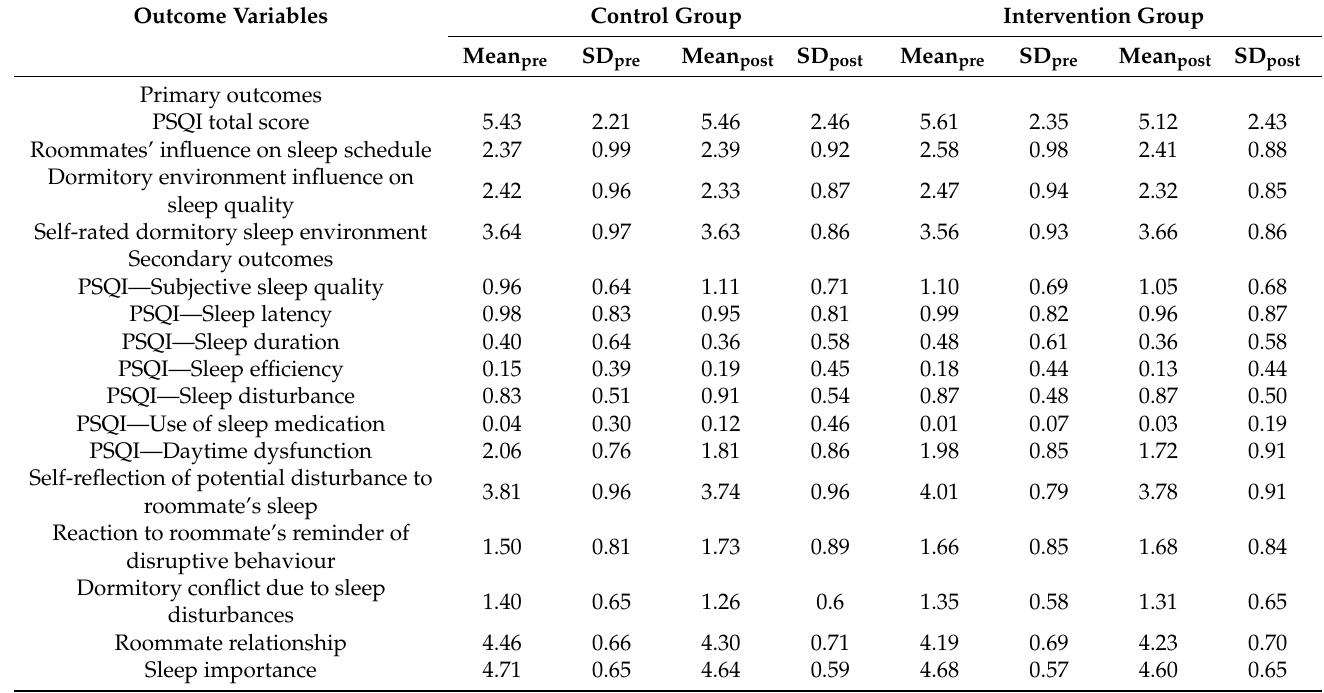
Table 2. Pre- and post-intervention level of primary and secondary outcome variables in both groups.